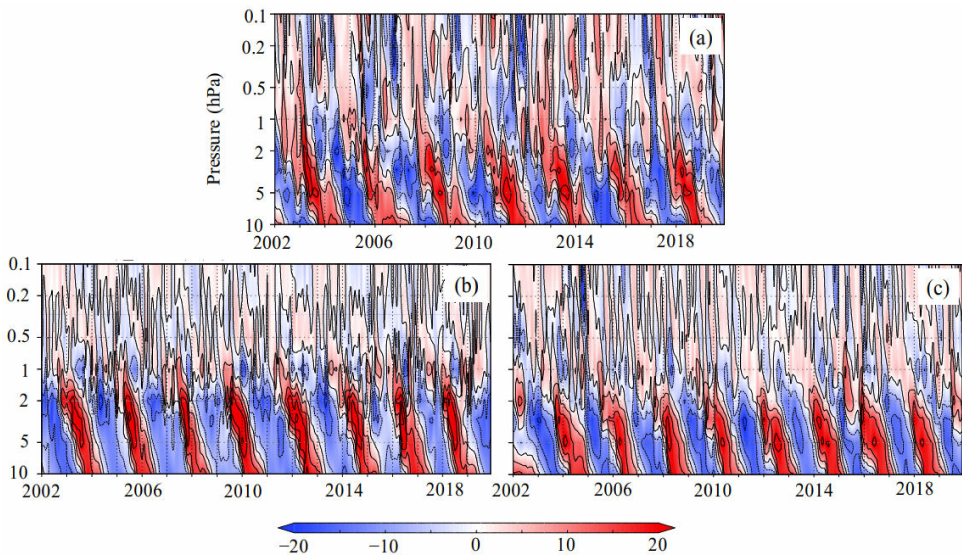
Figure 8. Time–height cross-sections of zonal–mean-zonal wind anomalies (ms − 1 ) averaged between 10 ◦ S and 10 ◦ N in the tropical upper stratosphere and mesosphere (10–0.1 hPa) for ( a ) the control run, the perpetual runs of ( b ) January, and ( c ) July. Contours interval is 7 ms − 1 .